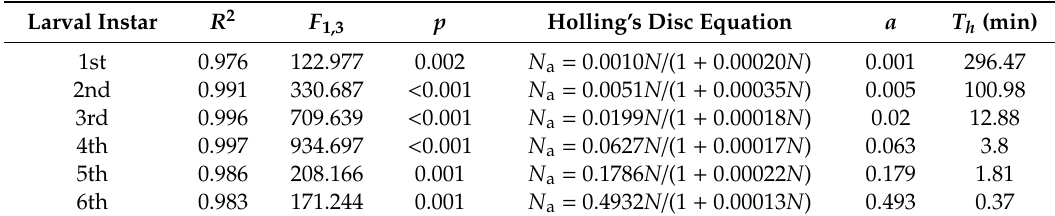
Table 2. Parameter estimates of the Holling’s disc equation (Equation (2) for the consumption by the FAW larvae.